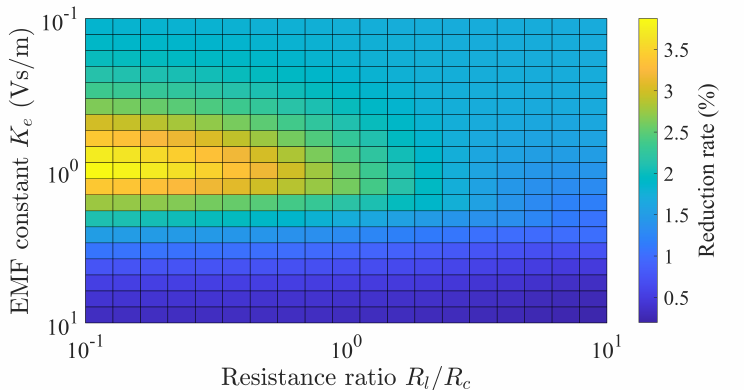
Figure 9. Simulated results of the torque ripple’s reduction rate as a function of load resistance and EMF